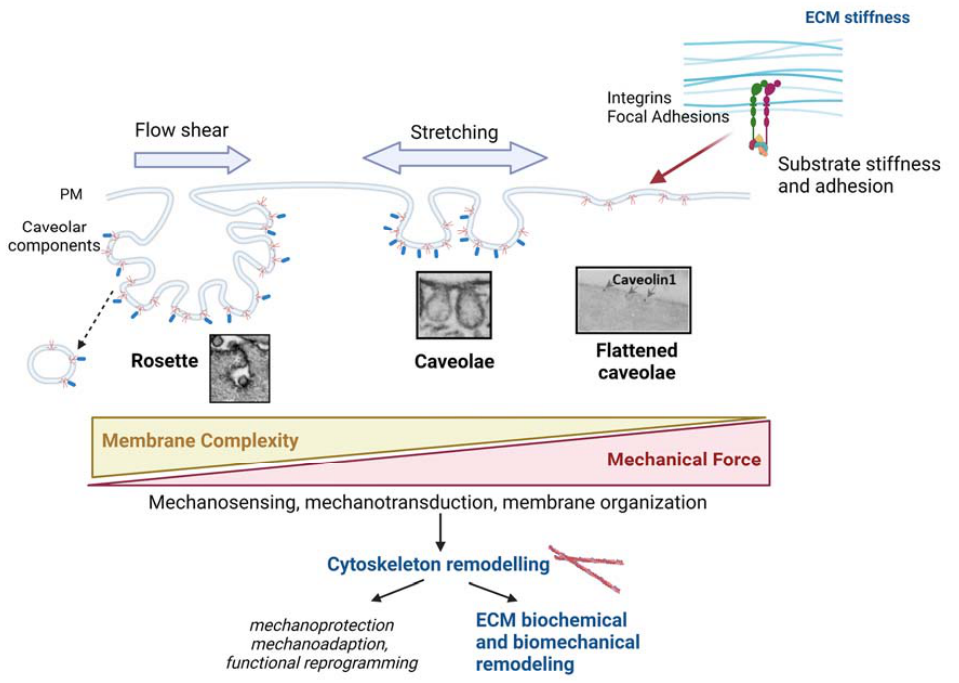
Figure 4. Schematic integrating the role of caveolae in mechanosensing (including ECM stiffness) and mechanotransduction (including cytoskeleton reshaping, and subsequent ECM remodelling). Caveolar structures exhibit high plasticity, such that upon reduced PM tension higher-order structures named ‘rosettes’ -vacuoles surrounded by clusters of caveolae connected through a single neck to the PM- are formed. Rosettes can flatten in response to mechanical challenges, such as shear stress, stretching or substrate stiffness, leading to the formation of single-pit caveolae. Further PM tension increase results in complete flattening and thus caveolae disassembly. Therefore, there is an inverse correlation between the complexity of Cav1-bound membrane and PM tension. Regulatory pathways integrate to control the plasticity, trafficking and mechanosensing and mechanostransducing abilities of caveolae, which lead to changes in the cytoskeleton, which in turn results in ECM remodeling through different effector mechanisms and in different functional outcomes for adapting to the surrounding mechanical stimuli. Created with BioRender.com accessed on 6 March